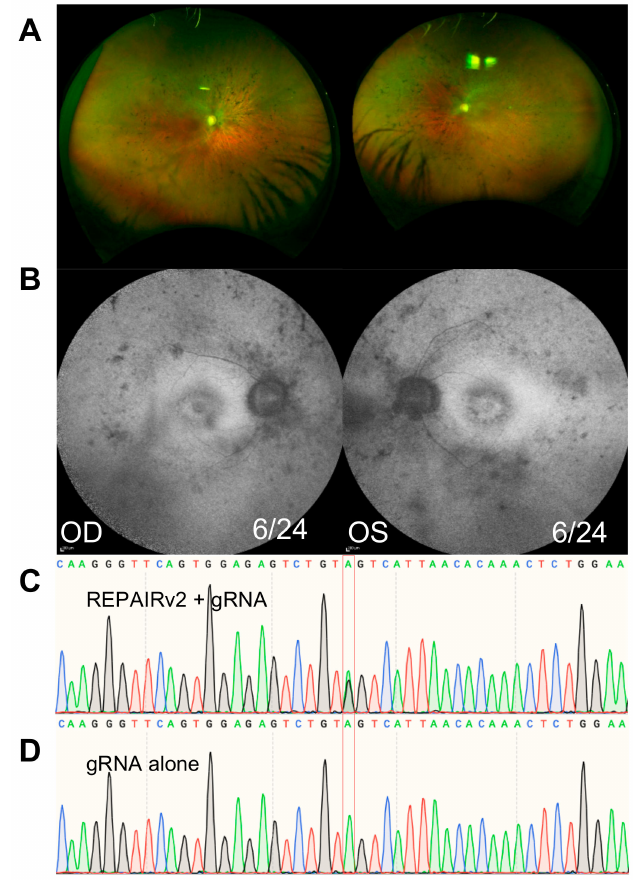
Figure 5. An approach to RNA editing in a patient with Usher Syndrome type 2 with compound heterozygous mutations in USH2A (c.2299delG / c.11864G > A). ( A ) Fundus photographs and ( B ) fundus autofluorescence images demonstrating pigmentary retinopathy and narrowing of the